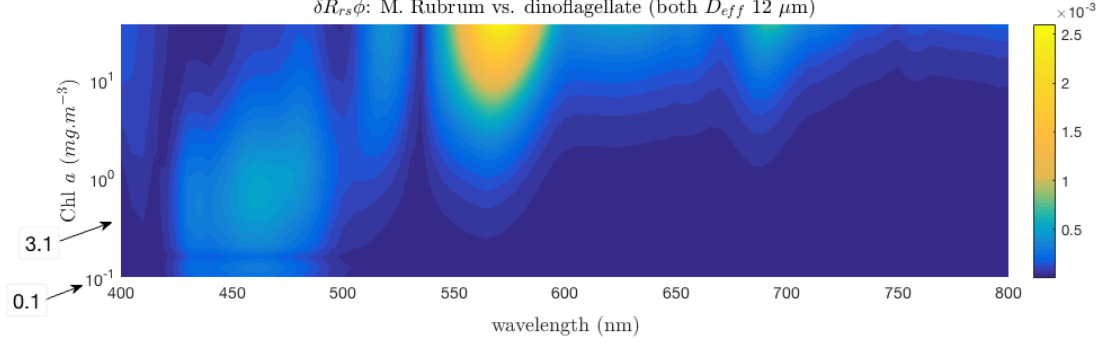
Figure 8. δ R rs shown for a change from a high biomass Myrionecta rubra -dominated assemblage, to a high biomass peridinin (carotenoid)-containing dinoflagellate-dominated assemblage. There is no change in D ef f